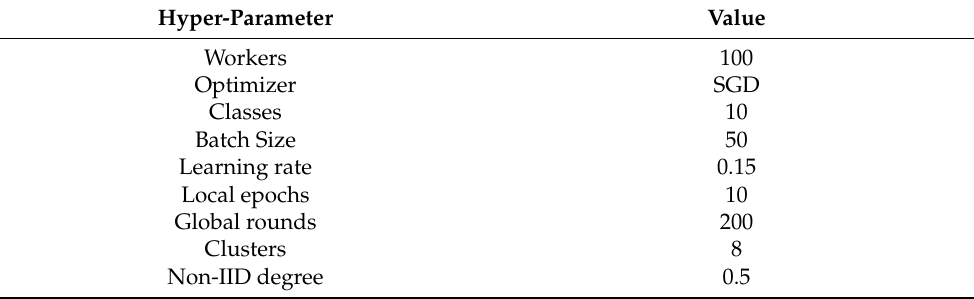
Table 3. Hyper-parameter